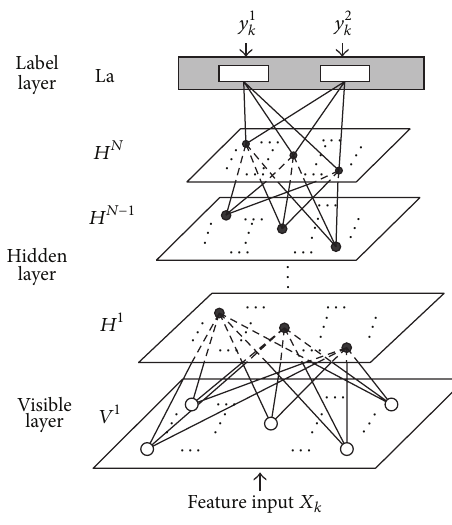
Figure 4: Proposed DBN for vehicle candidate